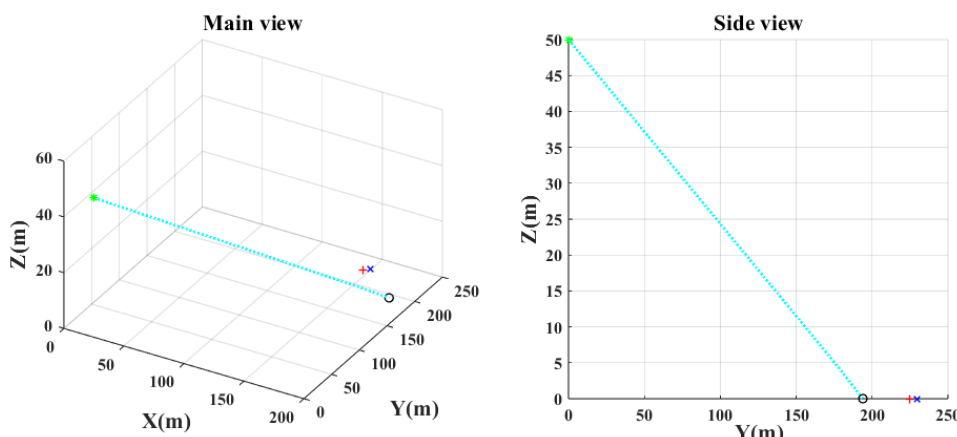
Figure 14. The ballistic of PSO in case 2.